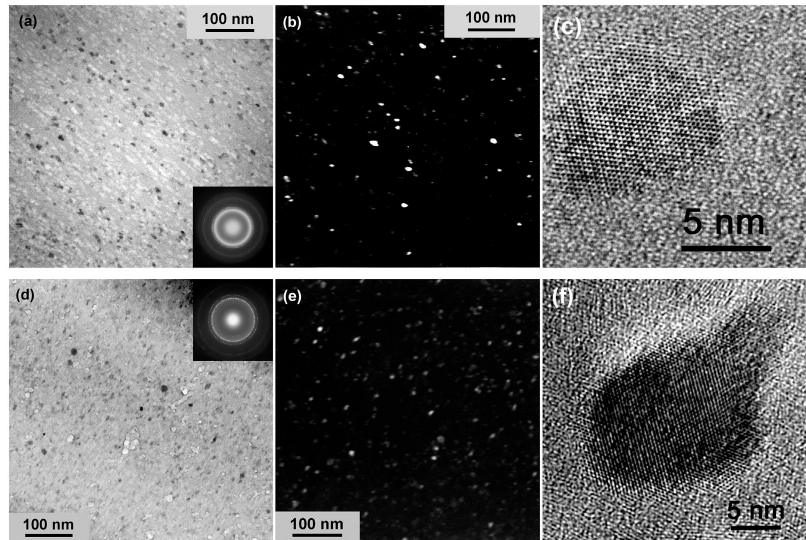
Figure 14. Microstructure of the Al 90 Y 10 alloy subjected to deformation at n = 0.1 ( a – c ) and n = 2 ( d – f ). ( a , d ) — BF images, ( b , e ) — DF images, inserts — corresponding SAED patterns, ( c , f ) — HRTEM images of individual Al crystals having formed after deformation. Reprinted with permission from ref. [94]. Copyright 2017 Elsevier.